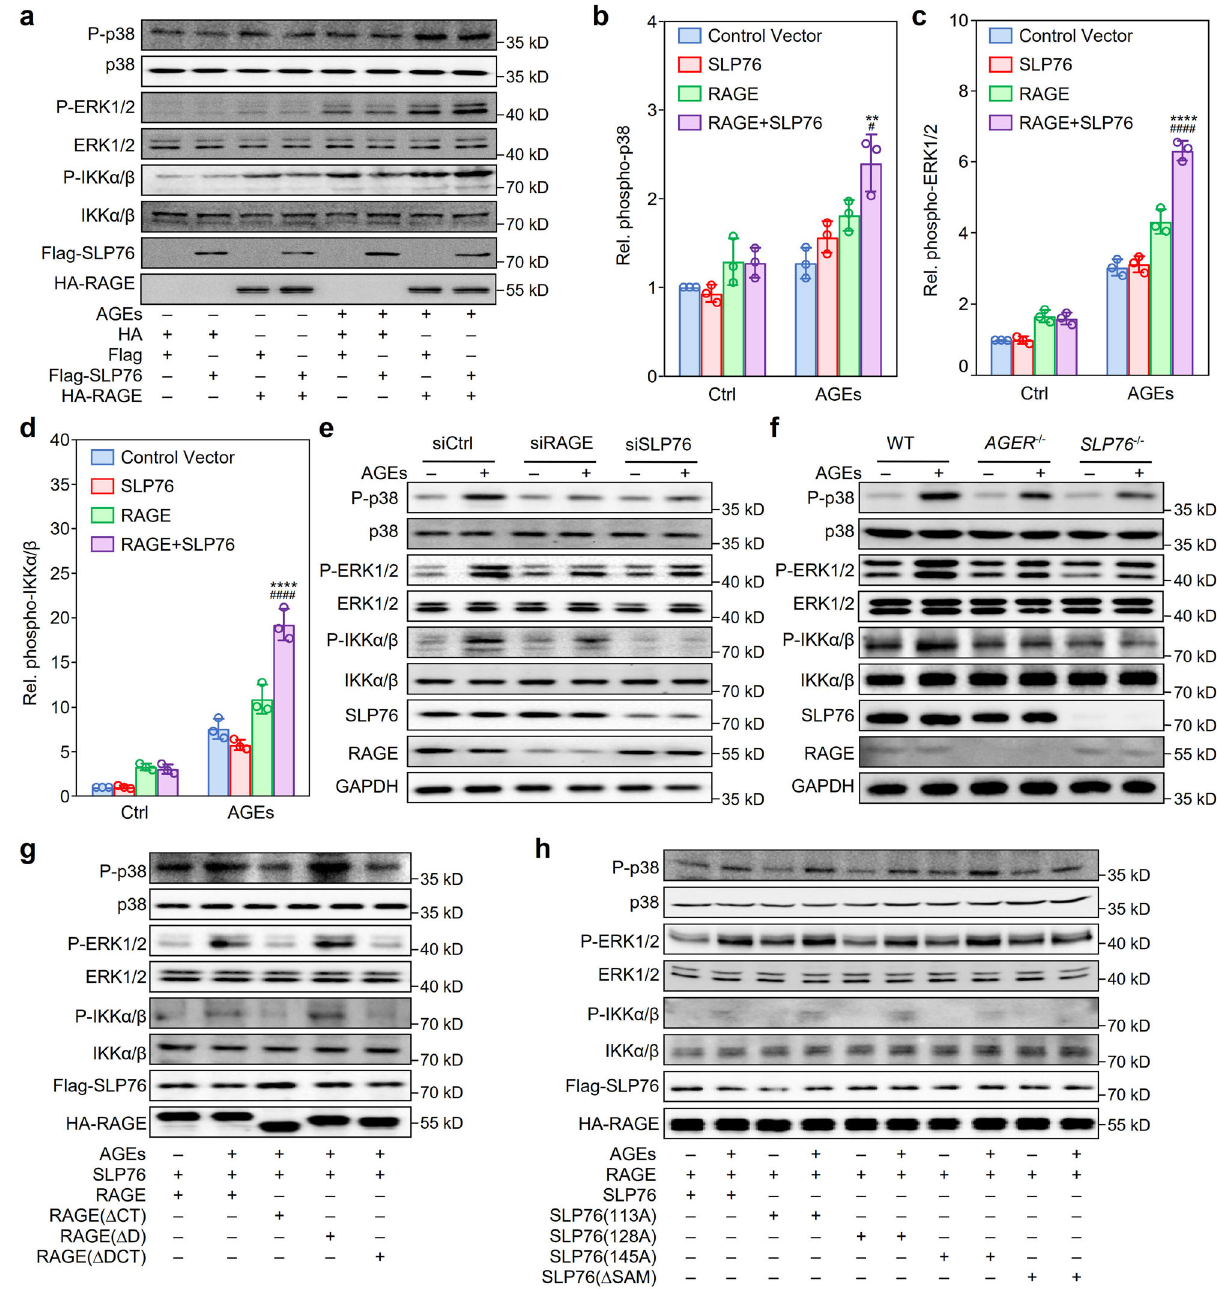
Fig. 4 Function of SLP76 in RAGE-mediated activation of proin fl ammatory signaling pathways. a Effects of RAGE and SLP76 overexpression on proin fl ammatory signaling pathways in HEK293 cells treated with AGEs. Flag-tagged SLP76 and HA-tagged RAGE were overexpressed together or separately in HEK293 cells treated with or without AGEs (100 μ g/ml) for 15 min. Plasmids expressing a Flag or HA tag were used as controls. Phosphorylation of MAPKs and IKK α / β was detected by western blotting ( n = 3). b – d Quanti fi cation of phosphorylated protein kinases activated by treatment with AGEs. The levels of phosphorylated p38 MAPK ( b ), ERK1/2 ( c ), and IKK α / β ( d ) were quanti fi ed with ImageJ software. Data were from three independent experiments ( n = 3) and are shown as the mean ± SD. ** P < 0.01, **** P < 0.0001 versus the group transfected with SLP76 alone, #### P < 0.0001 versus cells transfected with RAGE alone (one-way ANOVA plus Tukey post hoc). e Effects of RAGE and SLP76 on AGE-induced activation of p38, ERK1/2, and IKK α / β in RAW264.7 cells. After transfection with control siRNA or with speci fi c siRNA targeting AGER or SLP76 for 48 h, RAW264.7 cells were stimulated with AGEs (100 μ g/ml) for 15 min ( n = 3). f BMDMs isolated from WT, AGER knockout ( AGER − / − ), and SLP76 knockout ( SLP76 − / − ) mice were treated with AGEs (100 μ g/ml) for 15 min. Cells were harvested for detection of p38 MAPK, ERK1/2, and IKK α / β phosphorylation. The results represent three independent experiments ( n = 3). g Effect of the intracellular region of RAGE on AGE-induced activation of signaling pathways. Flag-tagged full-length SLP76 and HA-tagged WT RAGE or RAGE deletion mutants were overexpressed in HEK293 cells. After treatment with AGEs (100 μ g/ml) for 15 min, cells were harvested to detect phosphorylation of p38 MAPK, ERK1/2, and IKK α / β ( n = 3). h Role of the SLP76 domain interacting with RAGE in AGE-induced activation of p38 MAPK, ERK1/2, and IKK α / β . HEK293 cells were cotransfected with plasmids expressing HA-tagged RAGE and Flag-tagged WT SLP76 or mutant SLP76. After transfection for 24 h, cells were treated as indicated. Western blotting was performed to detect phosphorylation of p38 MAPK, ERK1/2, and IKK α / β ( n = 3). Source data are provided as a Source data fi le. NATURE COMMUNICATIONS| (2021) 12:308 |https://doi.org/10.1038/s41467-020-20577-3|www.nature.com/naturecommunications